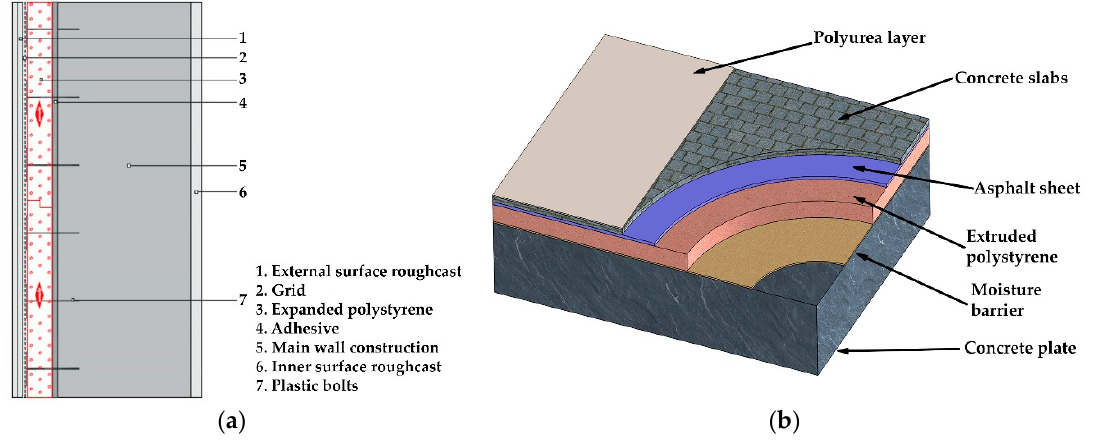
Figure 5. ( a ) Construction layout of external insulation on vertical surfaces. ( b ) Construction layout of external insulation on horizontal surfaces.